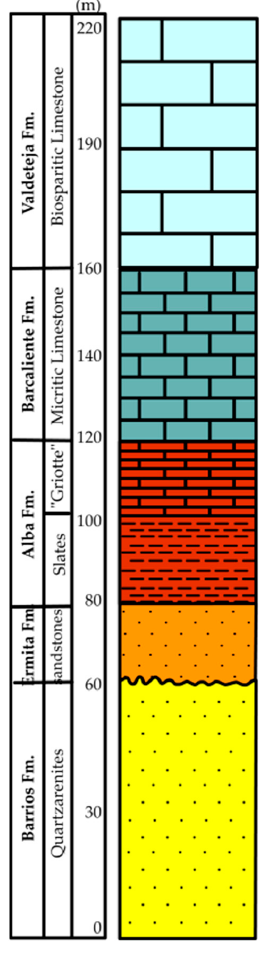
Figure 2. Stratigraphic column of the formations described in the text, between the beaches of La Ballota and Andrín (adapted from Ana-Cubero [14]). Note: The third level of Alba Formation was omitted because its thickness could not be determined due to deterioration.